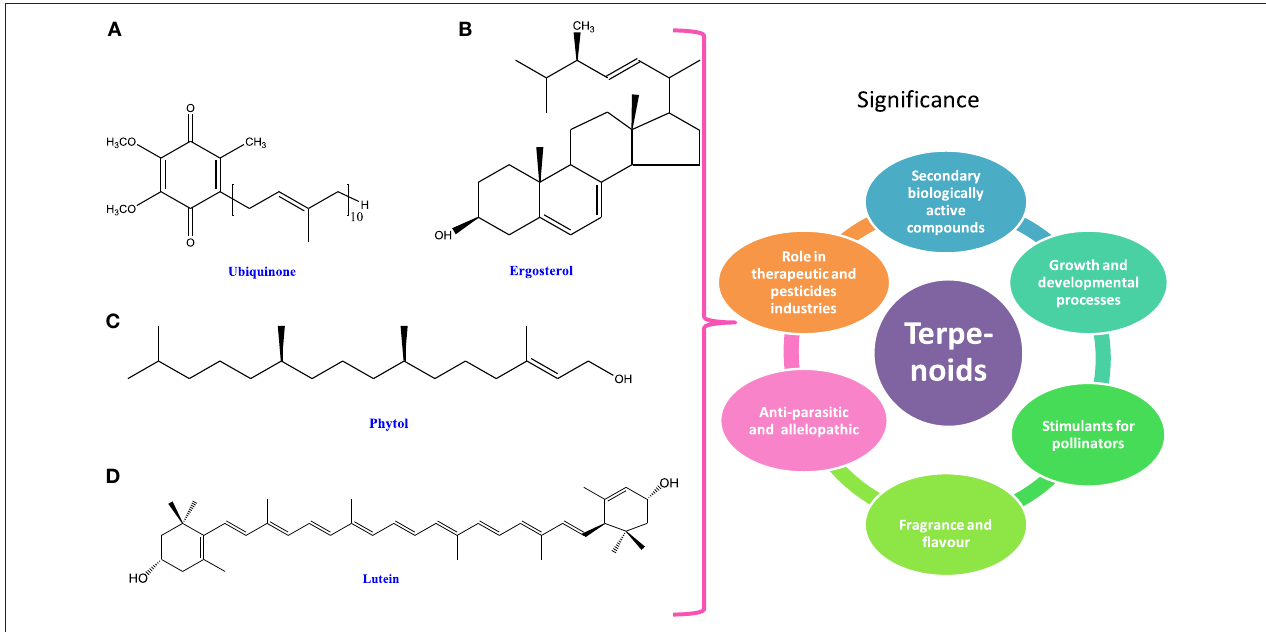
FIGURE 3 | Chemical structures and significance of terpenoid/ phytoene: (A) ubiquinone, (B) ergosterol, (C) phytol, and (D) lutein obtained from different cyanobacteria and